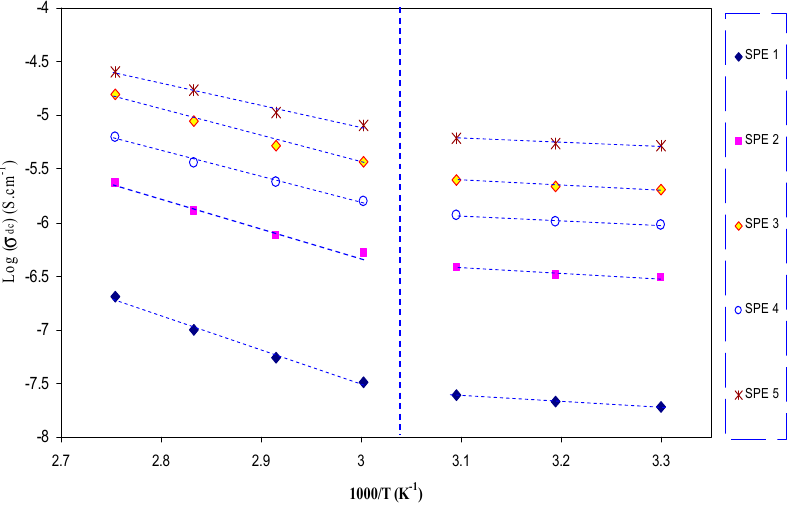
Figure 7. DC ionic conductivity versus 1000/T for PVA:AgNt SPE samples. The linear behavior of DC conductivity versus the reciprocal of temperature reveals that ion transport follows the Arrhenius model.